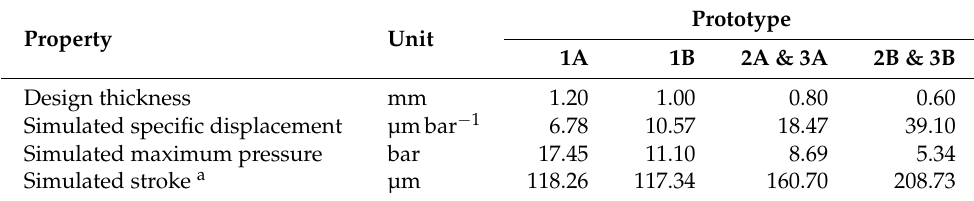
Table 1. Simulated specific displacements, maximum pressure and stroke for each prototype (number) and membrane (letter). Thicker membranes can withstand higher pressures before yield, but thinner membranes achieve a higher maximum stroke.